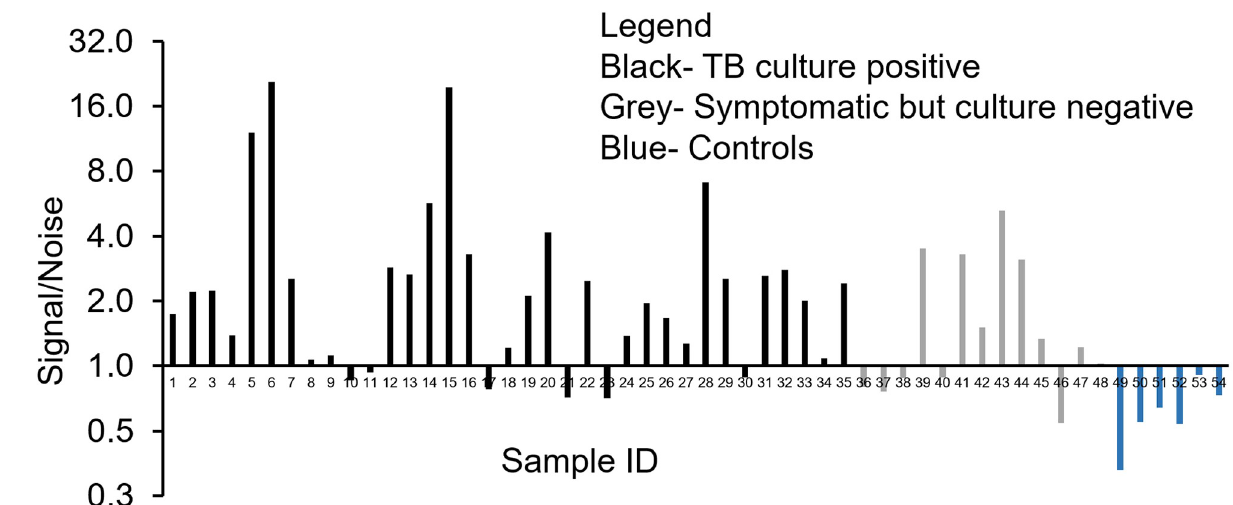
Fig 4. Direct detection of LAM in patient serum samples. Detection of LAM in clinical serum samples using the lipoprotein capture assay. Data are presented as the Signal/Noise (S/N) ratio with a value above 1.0 indicating a positive result. The measured S/N in sera from 54 patients from 3 different categories (see legend) is plotted. Results of urine testing using the Determine ™ TB LAM Ag assay at the time of enrollment into the clinical study: patients 1–20 were positive, patients 21–48 were negative, and healthy controls 49–54 were not